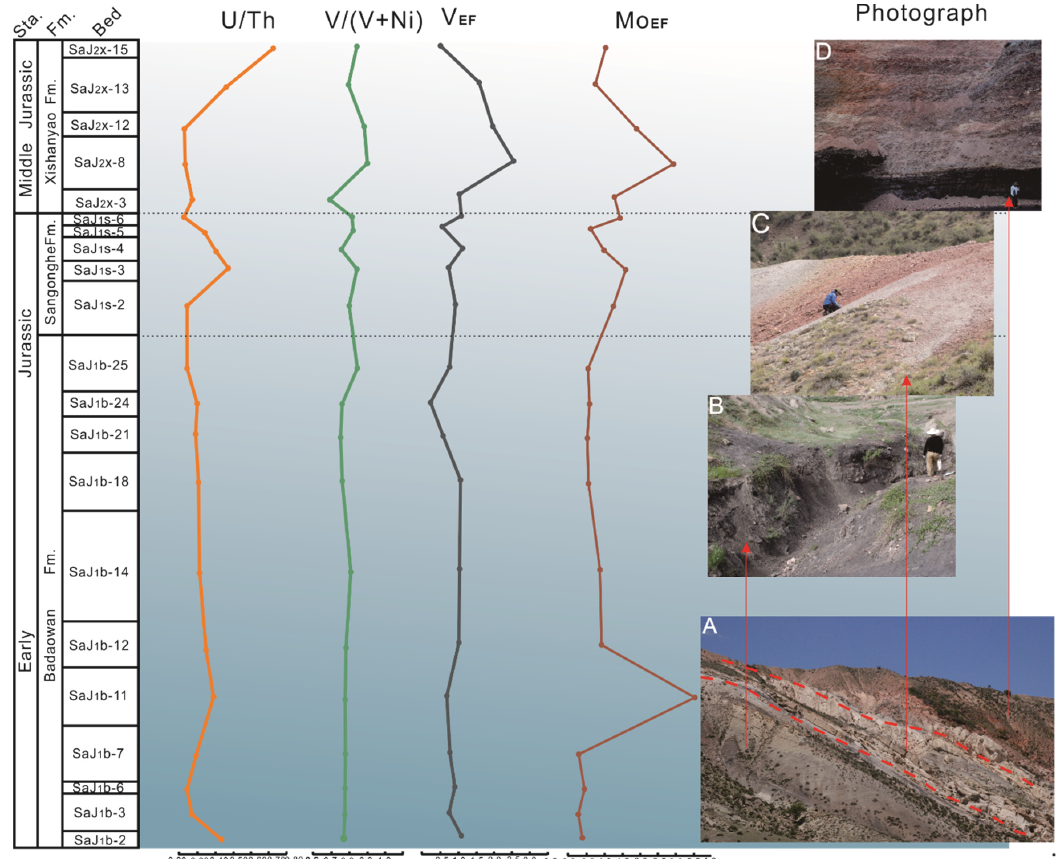
Figure 6. Redox-sensitive proxies (trace element ratios) and interpreted redox conditions from the Su’asugou section, Yili Basin. Photos to right of the geochemical stratigraphy are: ( A ) Overview of the Su’asugou section; ( B ) Black coal deposit in the Badaowan Fm.; ( C ) Red siltstone and greyish white sandstone in the Sangonghe Fm.; ( D ) Red burnt rocks in the Xishanyao Fm. Abbreviations: Sta.= Stage; Fm.= Formation.